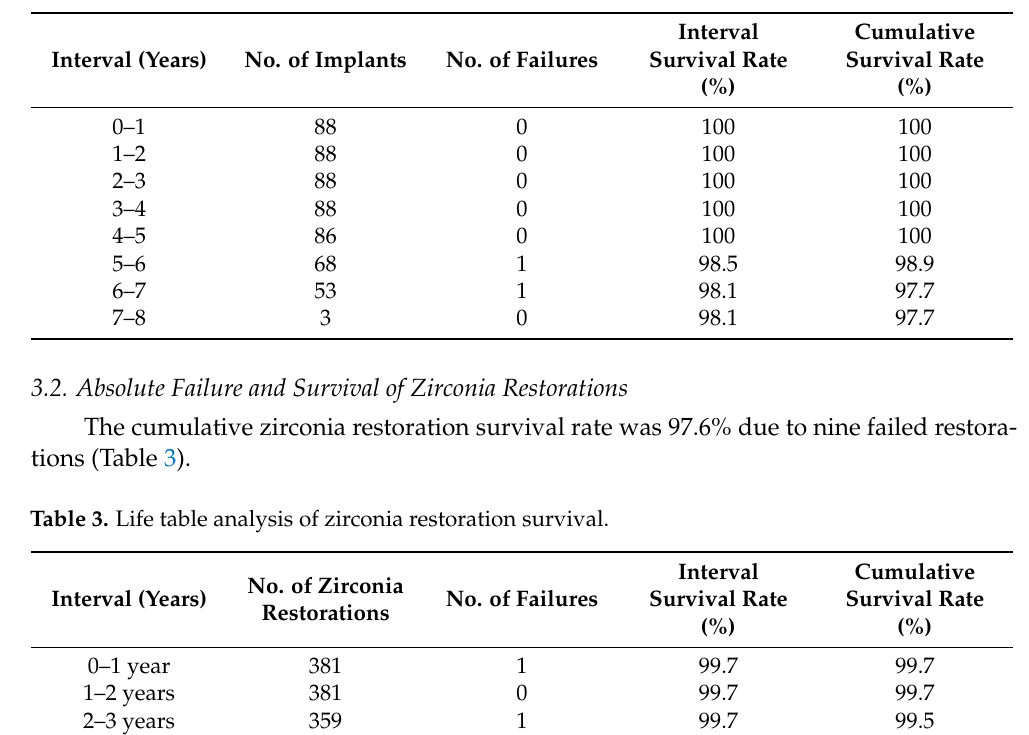
Table 2. Life table analysis of implant survival.